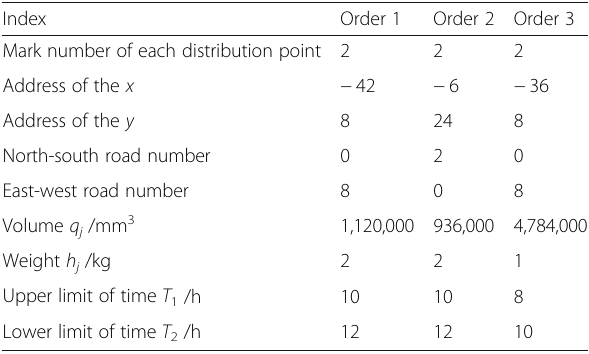
Table 4 Information on the collection of cargo (part) (scale is